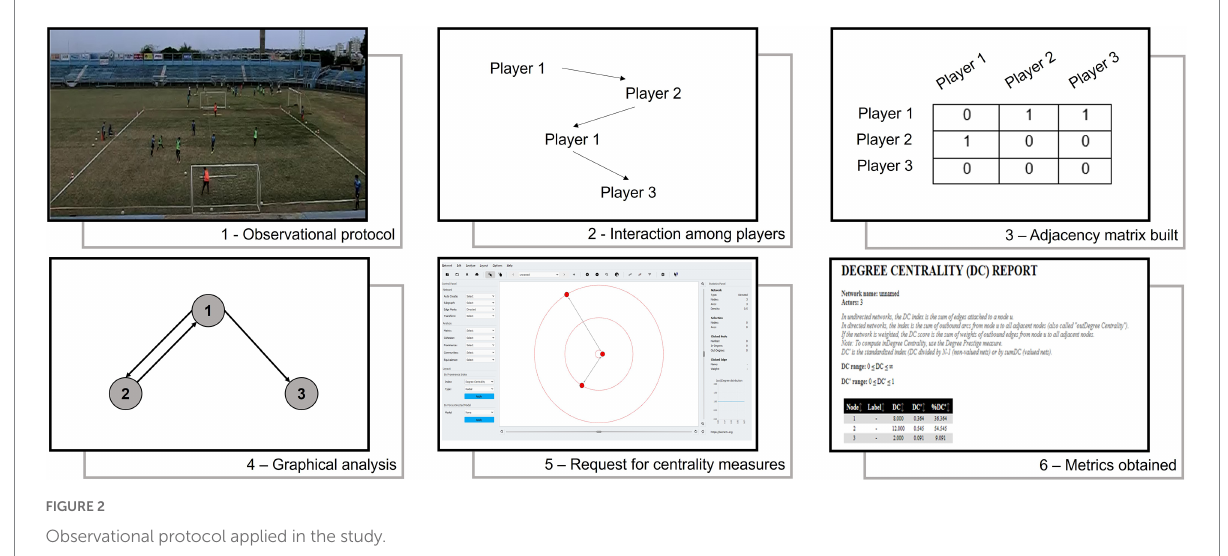
FIGURE 2 Observational protocol applied in the